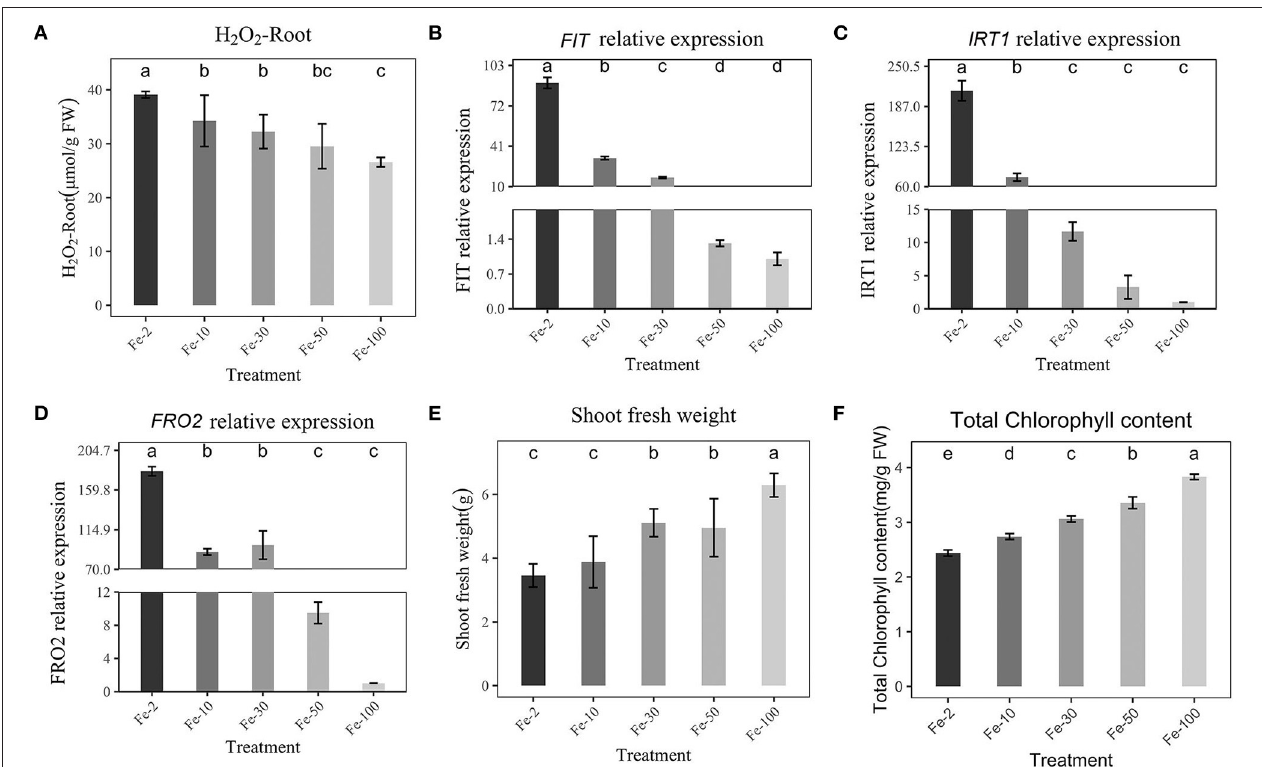
FIGURE 3 | Effects of Hoagland nutrient solution with different Fe concentration on peanut (A) : Effects of Hoagland nutrient solution with different Fe concentration on H 2 O 2 content. (B) : Effects of Hoagland nutrient solution with different Fe concentration on FIT expression. (C) : Effects of Hoagland nutrient solution with different Fe concentration on IRT 1 expression. (D) : Effects of Hoagland nutrient solution with different Fe concentration on FRO2 expression. (E) : Effects of Hoagland nutrient solution with different Fe concentration on fresh weight of shoot. (F) : Effects of Hoagland nutrient solution with different Fe concentrations on chlorophyll content. Data and errors are mean ± SD, n = 6, and different letters indicate significant differences among treatments. p < 0.05. (Fe-2 10, 30, 50, 100, different number means different FeEDTA( µ mol) in Hogland